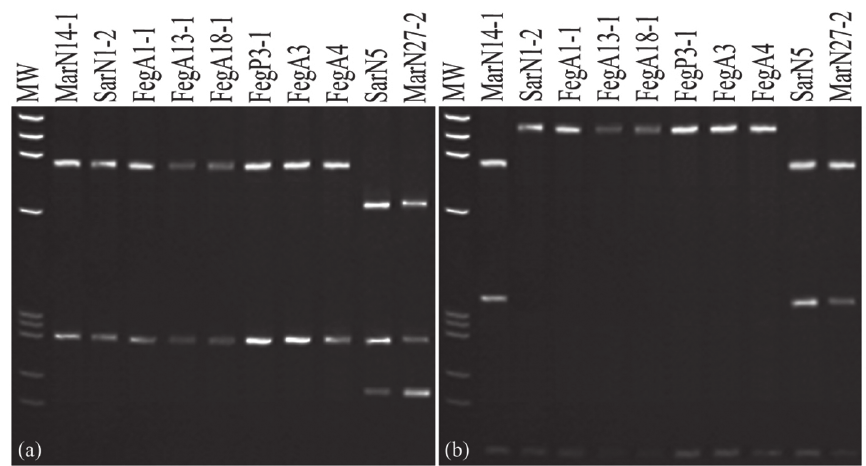
Figure 3. Actual gel-based Bst UI- and Taq I-RFLP patterns of R16F2nR2 amplicons from ‘ Ca. P. phoenicium’ strains. Acronyms are described in Table 1; MW, FX174DNA digested by Hae III, fragment size (bp) from top to bottom: 1353, 1078, 872, 603, 310, 281, 271, 234, 194, 118, 72. Restriction fragments were visualized by electrophoresis through 3% agarose